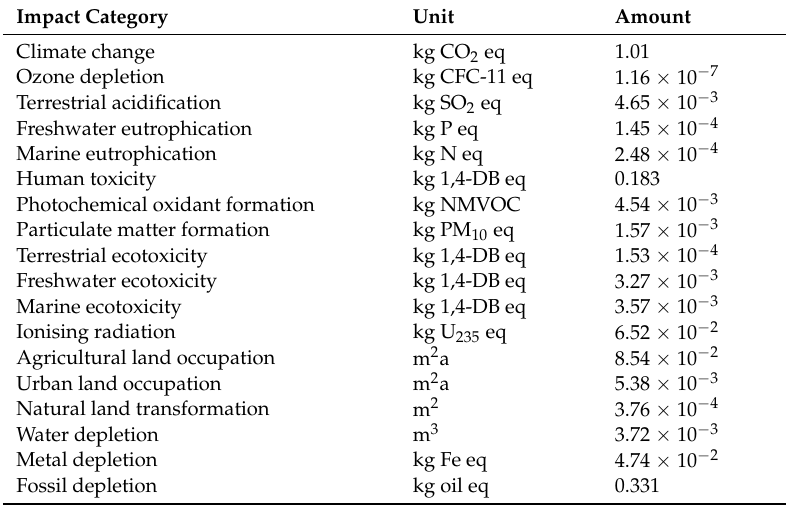
Table 2. Characterisation results for the 30% assumption—extracted from SimaPro (Pr é 2018).